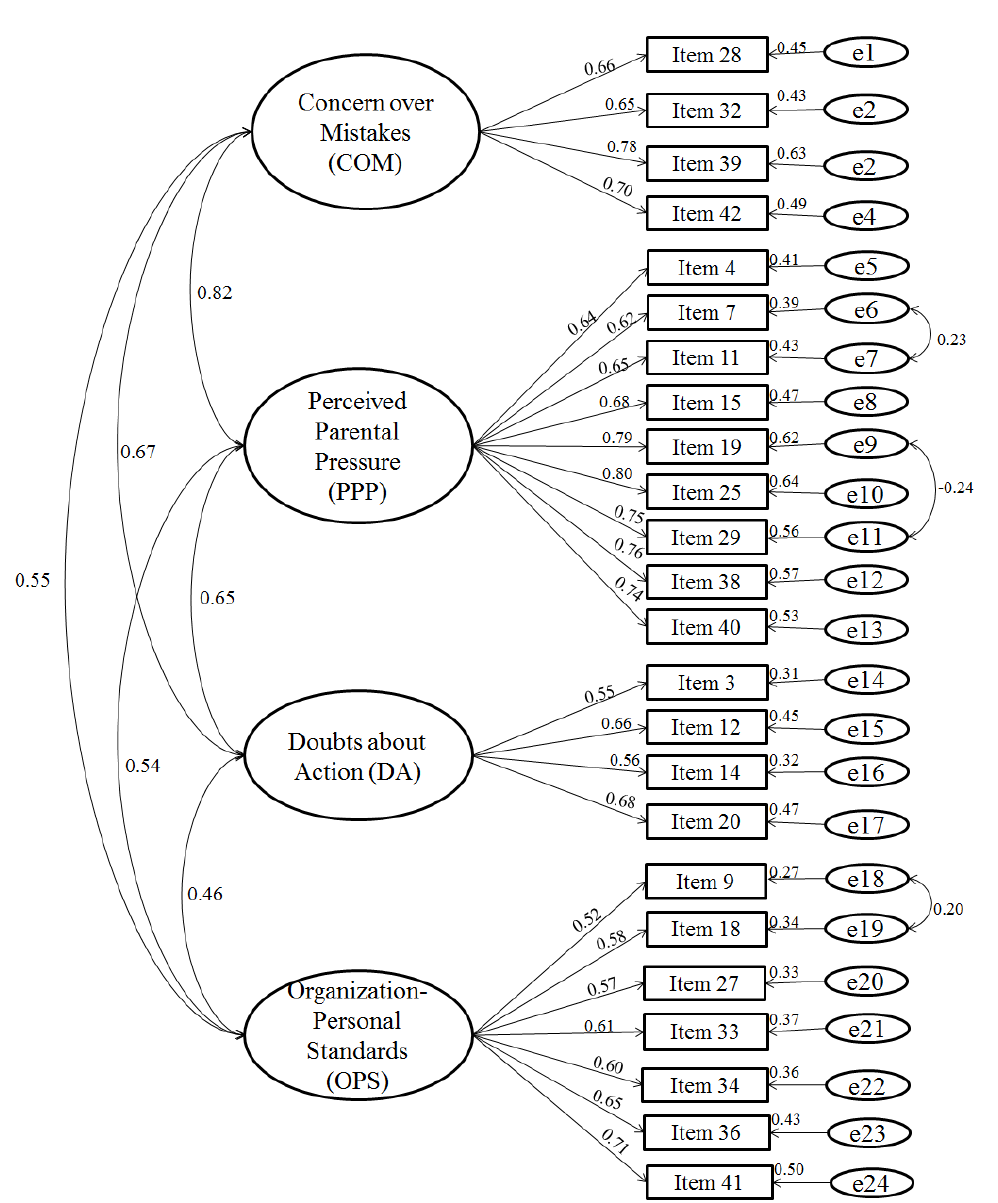
Figure 1. Bootstrap standardized coefficients, correlation between factors and error associated to each item, in the 4-factors SMPS-2 modified model with 24